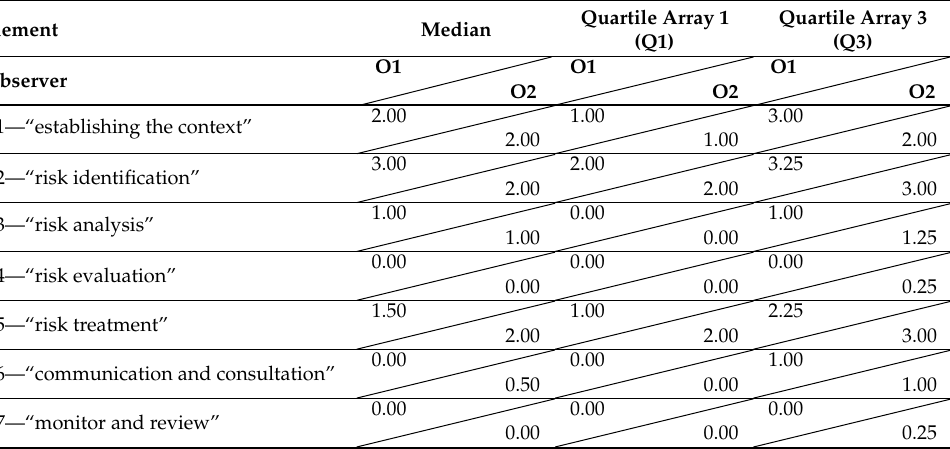
Table 4. Medians and interquartiles of competency of the control group for each of the elements of the risk management process as rated by the two observers in round two.